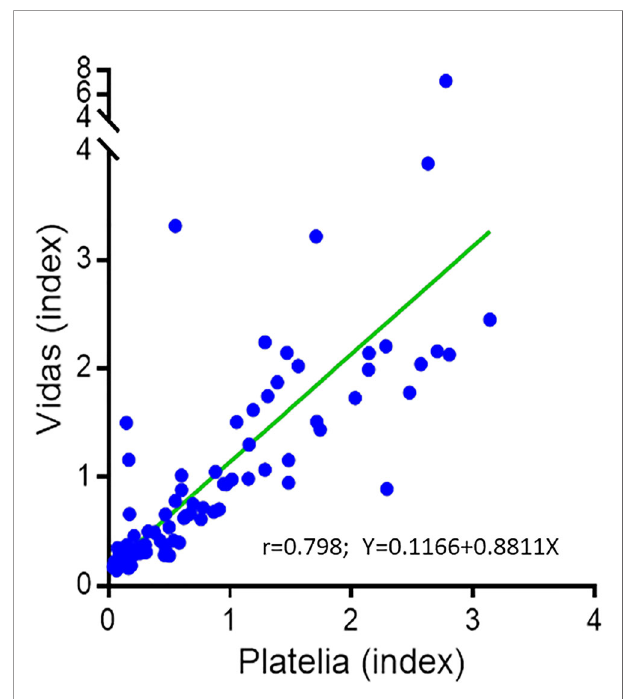
Figure 2 . Considering all 126 sera, the areas under the curve (AUC) ® were 0.808 and 0.827 for the VIDAS GM and Platelia assays, respectively. For the sera collected 15 days before or after the date of the IA diagnosis AUC of the two assays were better and similar (0.892 and 0.894, respectively). The cut-offs and results that